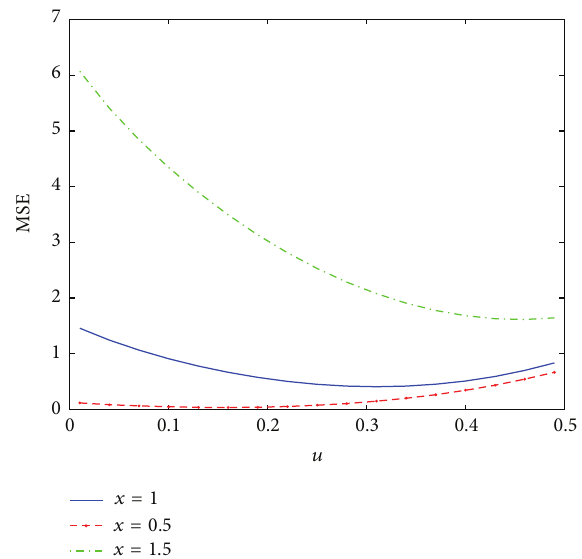
Figure 5: MSE of (15) at 𝑥 = 0.5 , 𝑥 = 1 , and 𝑥 = 1.5 .